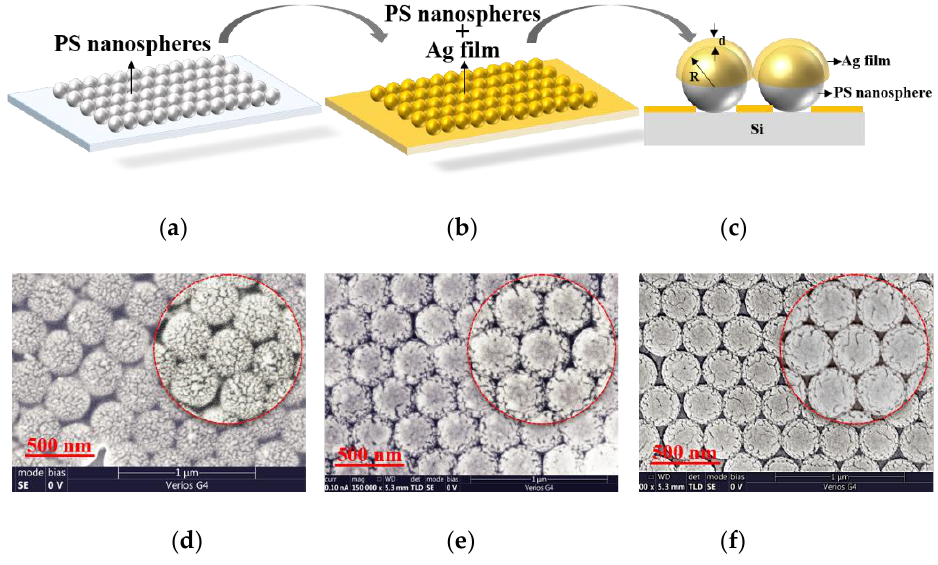
Figure 1. ( a – c ) Sketch map of the fabrication process of the Ag-film semi-coated PS nanosphere array; ( d – f ) SEM image of the Ag-film semi-coated PS nanosphere array with an Ag film thickness of d = 10